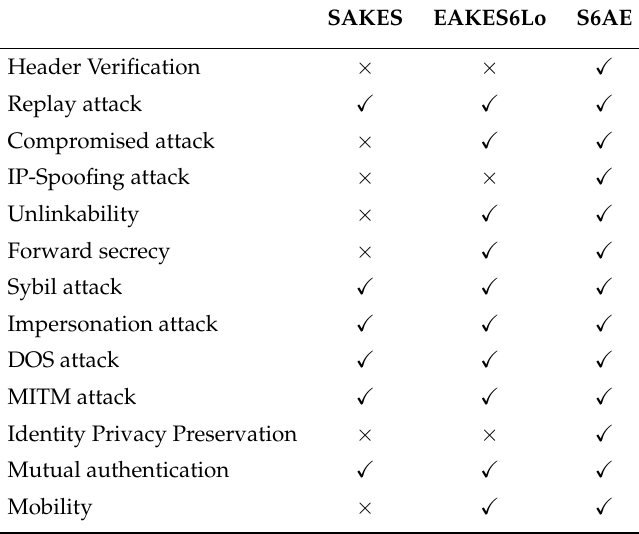
Table 5. Comparison of security properties.